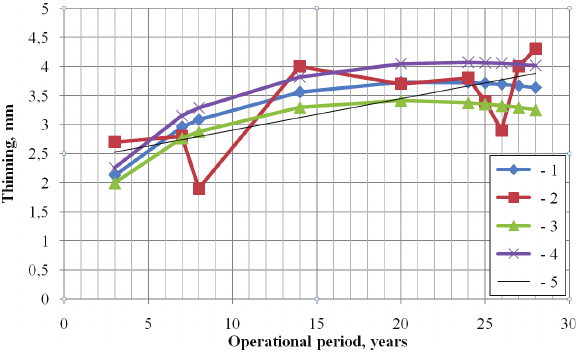
Figure 6. Correspondence between the control and forecast val- ues for the approximated Keller coefficient (feedwater pipeline): 1 – forecast; 2 – control; 3 – –∆; 4 – +∆; 5 – regression ( y = 0.054 x + 2.361; R 2 =